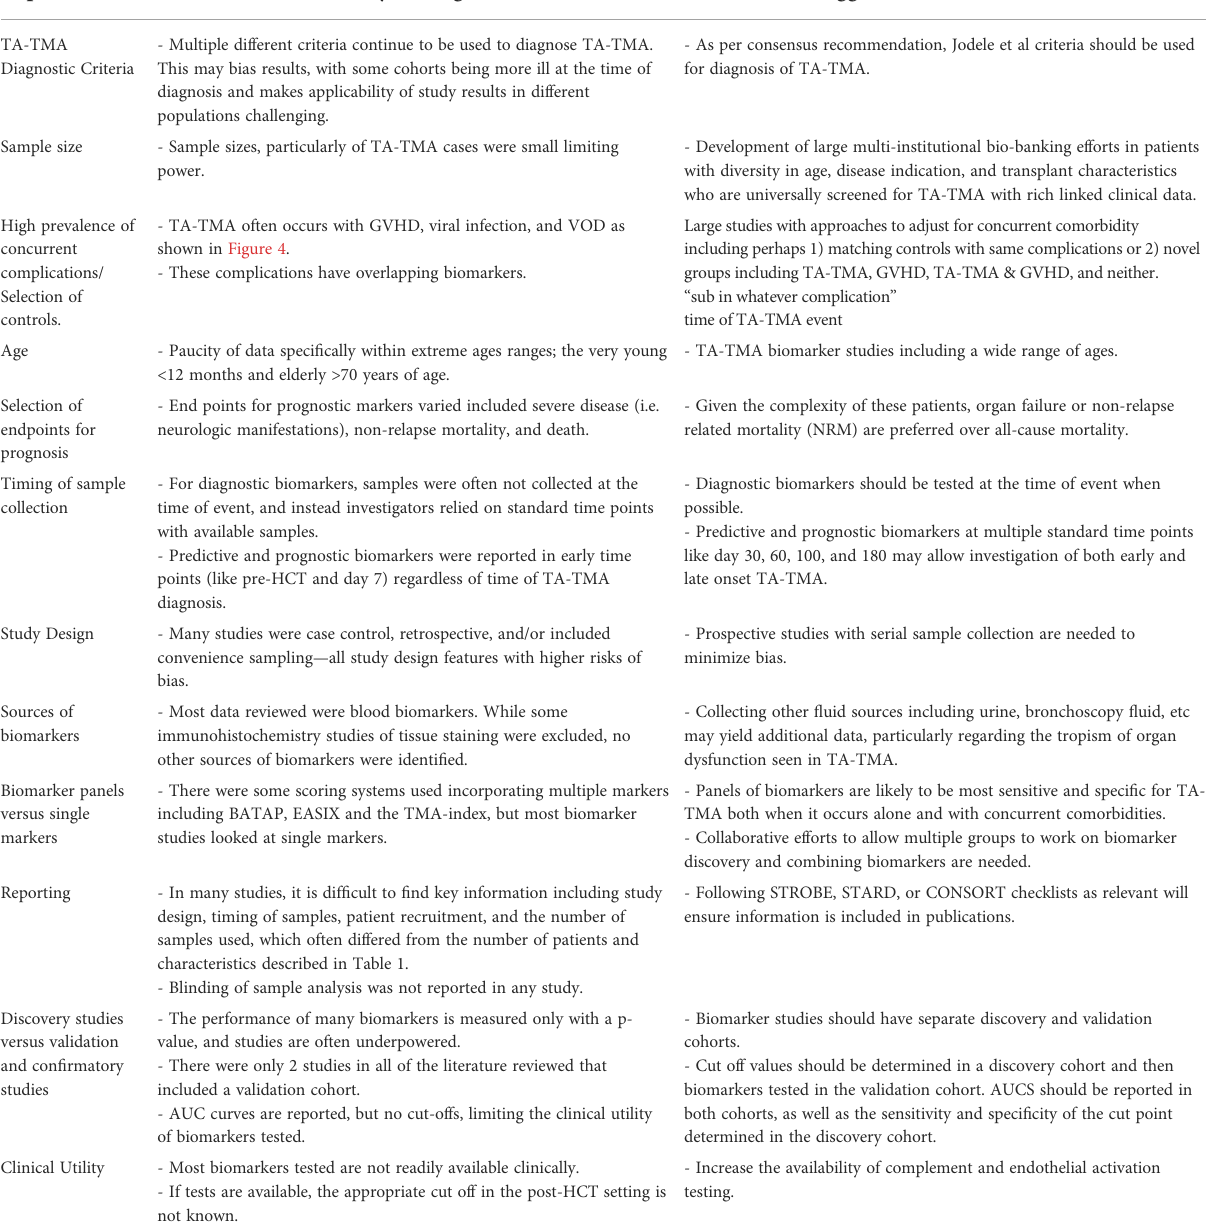
TABLE 6 Key fi ndings and suggestions for future